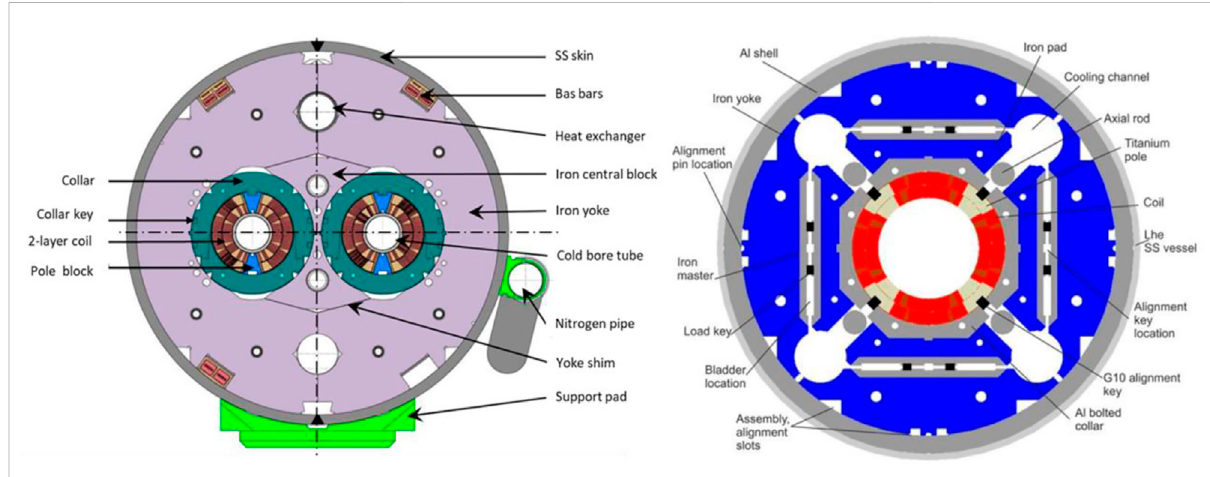
FIGURE 3 Left: cross-section of the 11 T dipole cold mass. Right: cross-section of the MQXF cold mass. The two cross-sections are not in